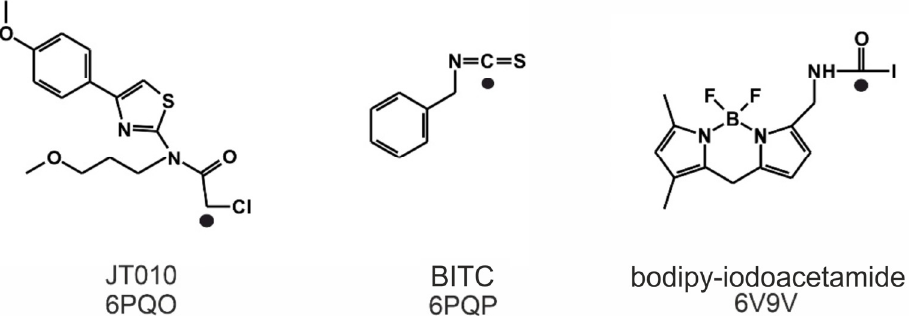
Figure 1. The Lewis structures of three TRPA1 agonists, JT010, benzyl-isothiocyanate (BITC) and bodipy-iodoacetamide, and the PDB IDs of their complexes with the TRPA1 receptor. The original molecular structures were restored prior to the covalent bond formation. A chlorine was added to JT010, an iodine to bodipy-iodoacetamide and the geometry of the N=C=S bond of BITC was restored. The atoms that participate in the formation of the covalent bond are marked by black dots.